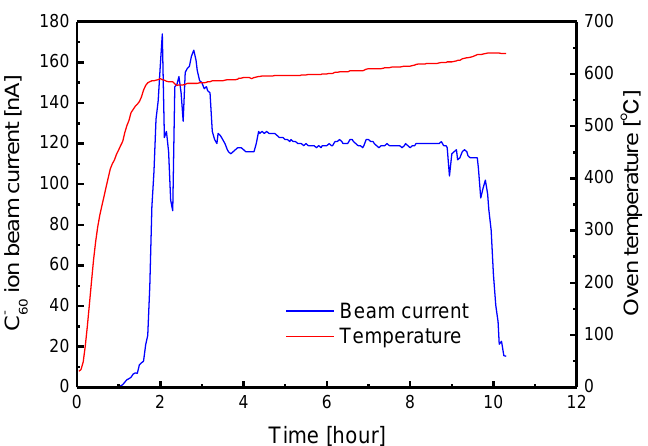
Figure 6. Example results of negative C 60 ion beam production using an oven rod with a built-in electron source: the negative C 60 ion beam current (blue line) and oven temperature (red line) as functions of time.